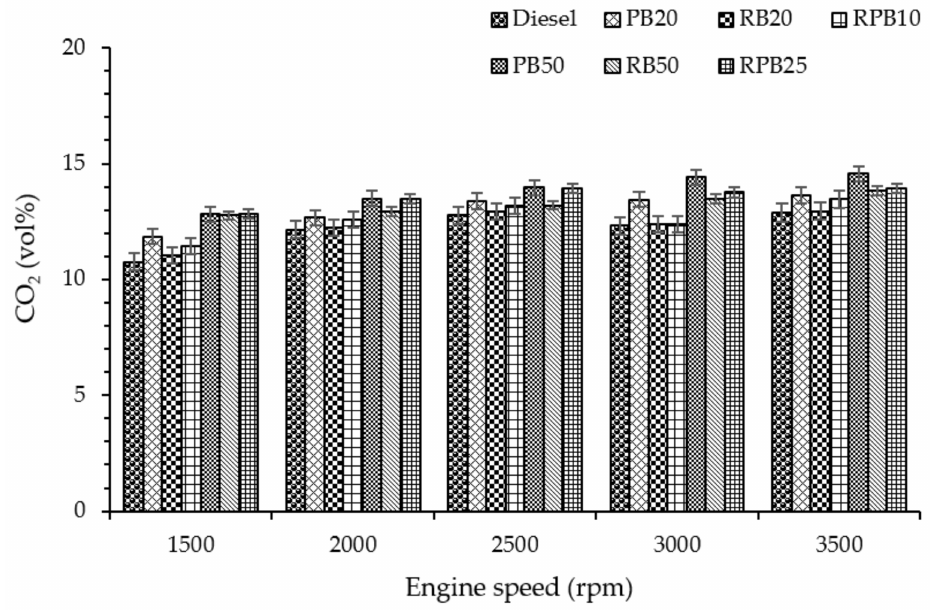
Figure 8. Variation of carbon dioxide (CO 2 ) emission with respect to engine